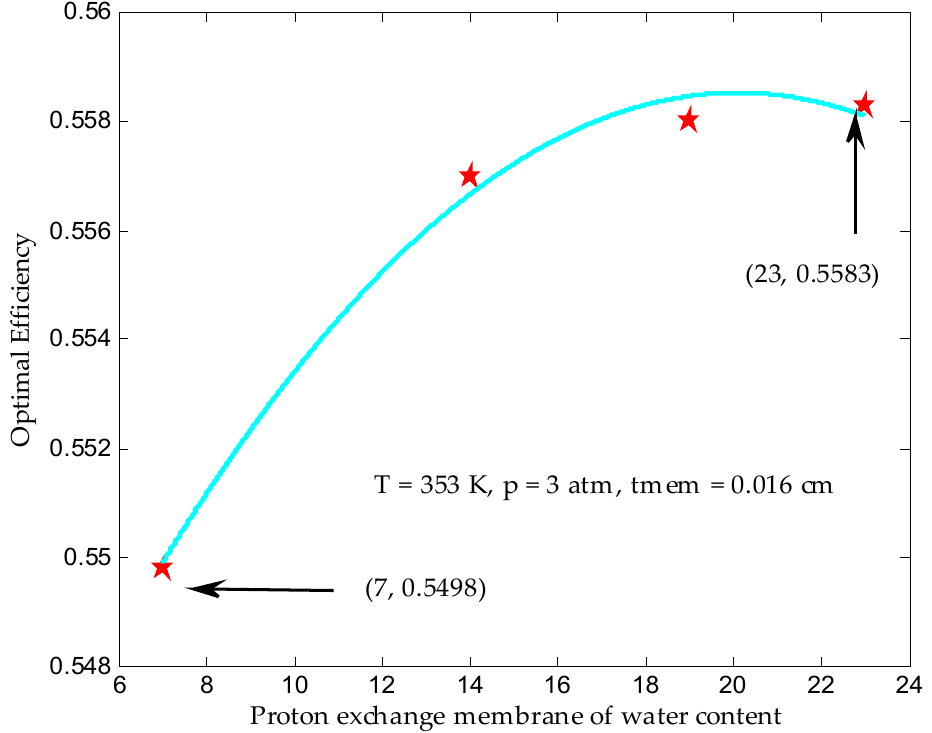
Figure 10. E ff ect of membrane water content on optimal output e ffi Figure 10. Effect of membrane water content on optimal output efficiency. Figure 10. Effect of membrane water content on optimal output efficiency.